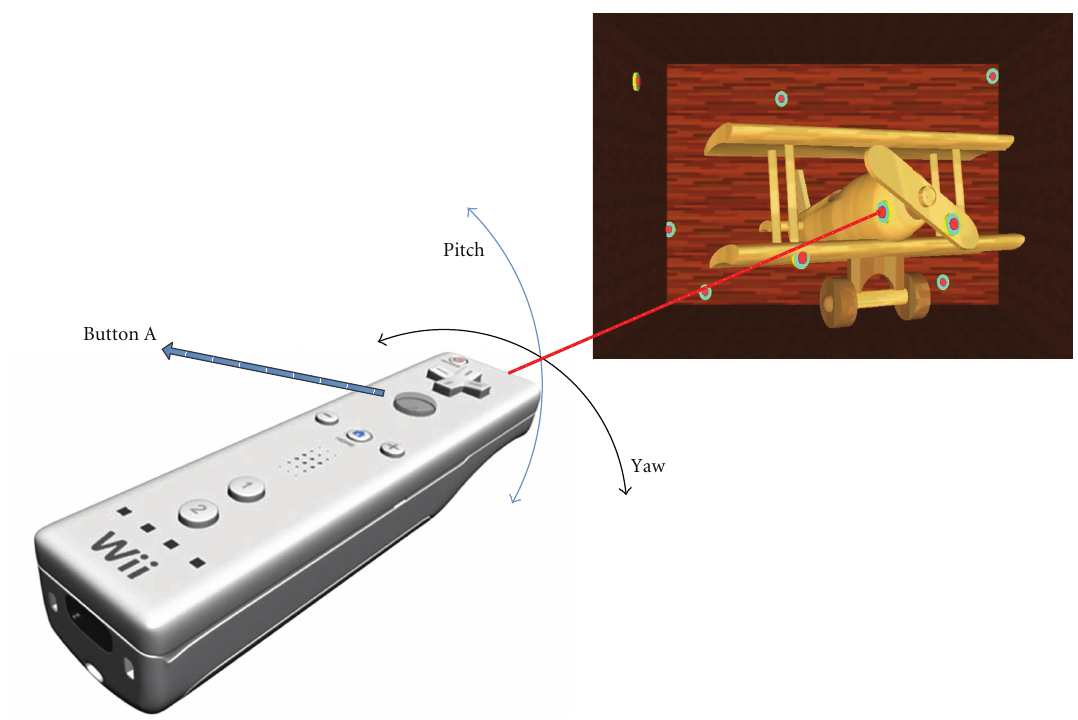
Figure 6: Ray-casting selection techniques using Wiimote with